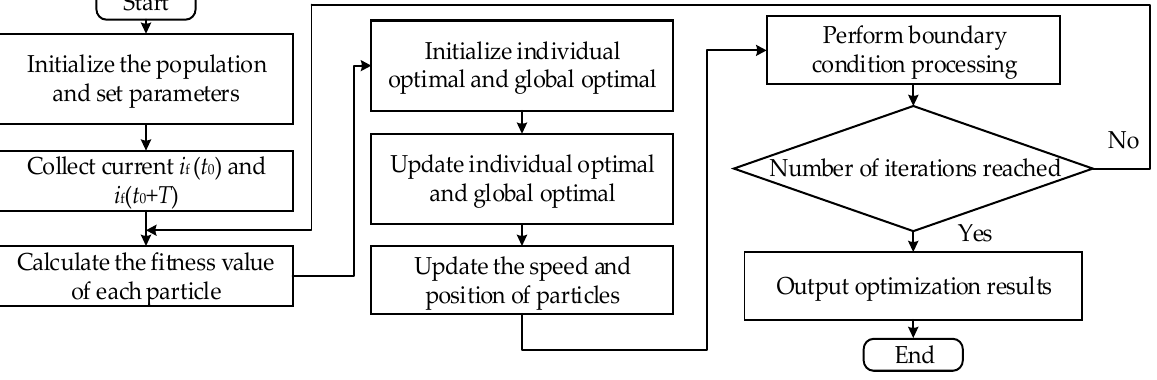
Figure 5. The flowchart of particle swarm optimization for mutual inductance identification. The specific steps are as